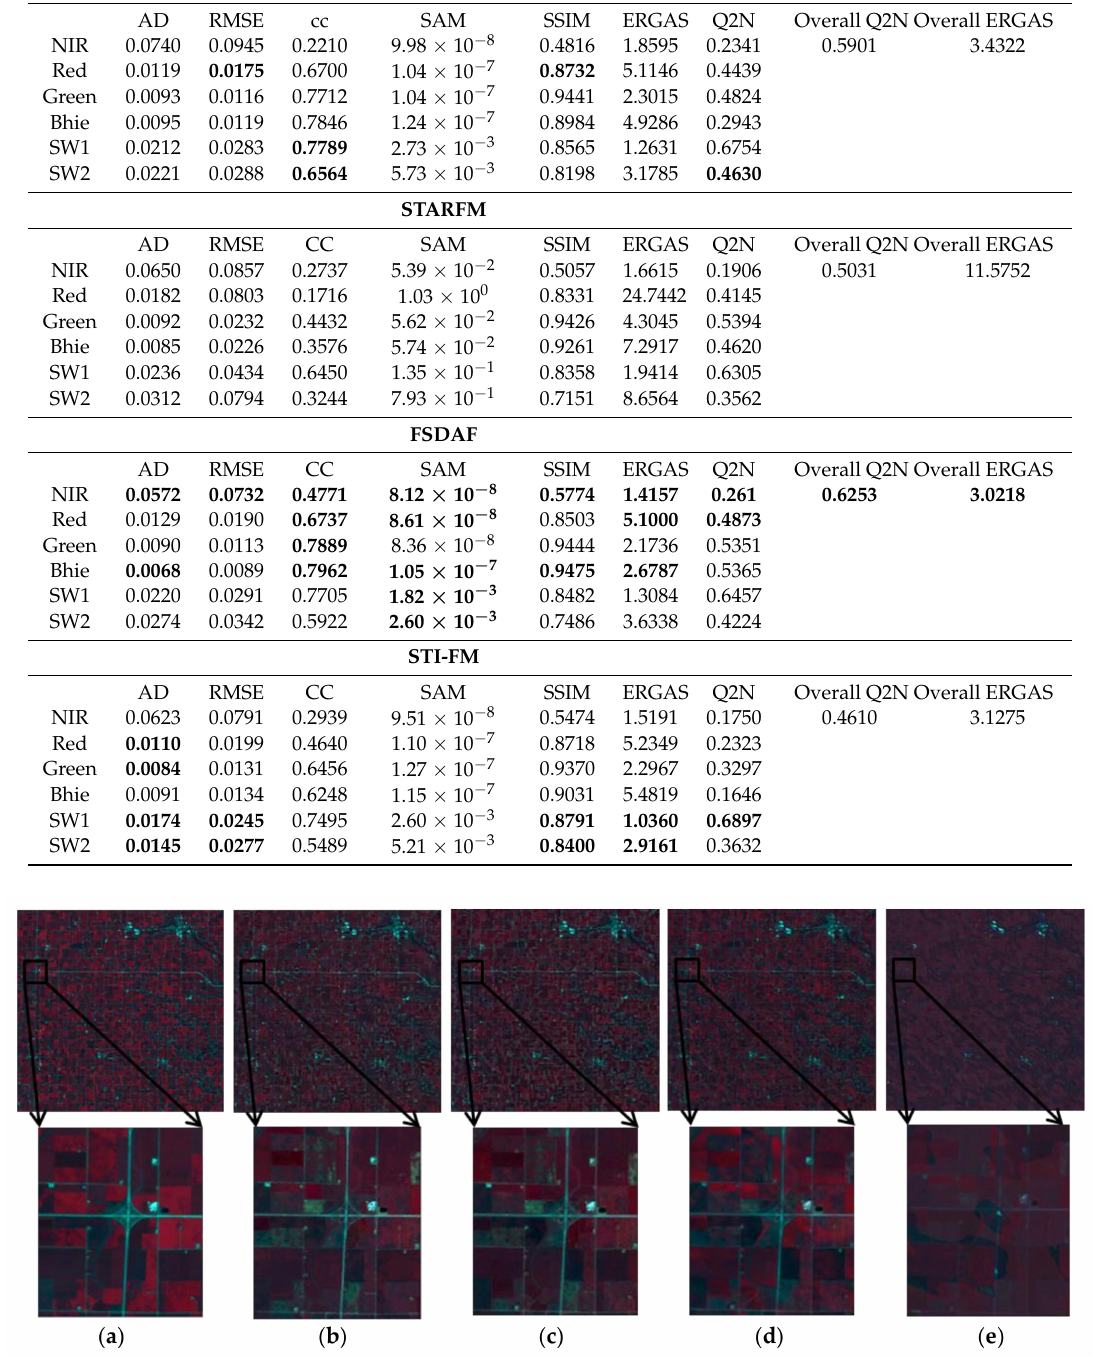
Figure 7. Comparison of forward prediction results of using Landsat image 182 to predict Landsat image 214. ( a ) Actual image; ( b ) STARFM; ( c ) FSDAF; ( d ) STI-FM; and, ( e )